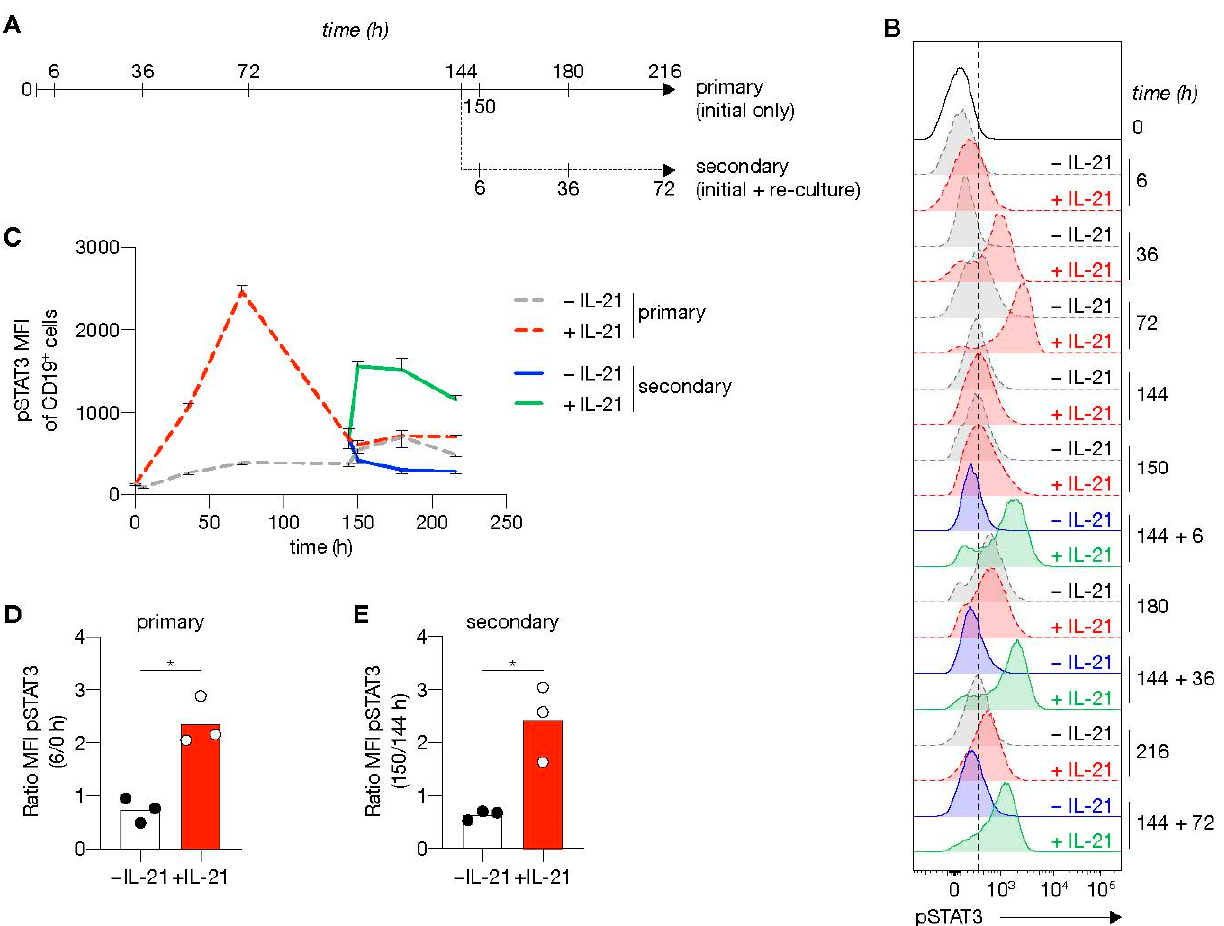
Figure 6. STAT3 is rapidly re-phosphorylated upon re-stimulation using CD40 costimulation and IL-21 signaling. ( A ) Overview of the time points sampled from primary and secondary human B-cell cultures. Human naive B-cells were cultured on 10,000 CD40L +++ -expressing 3T3 cells (as in Figure 1A) with or without IL-21 for 6 days. After 6 days, secondary cultures were initiated for 3 days with 10,000 CD40L +++ -expressing 3T3 cells with(out) IL-21 ( n = 3). ( B , C ) Representative plot of pSTAT3 levels ( B ) and quantification ( C ) at baseline and 6, 36, 72, 144, 150, 180 and 216 h in primary culture (dotted gray w/o IL-21 and red lines with IL-21); and 6, 36 and 72 in secondary culture (solid blue w/o IL-21 and green lines with IL-21). Data are shown as mean ± SEM ( n = 3 independent experiments). Single experiments were conducted in triplicate. ( D , E ) Fold induction of pSTAT3 6 h in primary ( D ) and secondary ( E ) cultures relative to time point 0 or 144 h. Each data point represents the mean of an individual experiment ( n = 3) with triplicate measurements. Mean values are represented as bars. p values were calculated using paired t-test. * P ≤